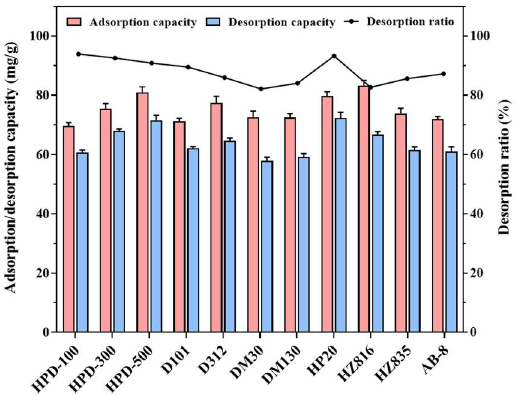
Figure 1. Static screening results of total flavonoids in Rosa setate x Rosa rugosa waste extracts on eleven macroporous adsorption resins.